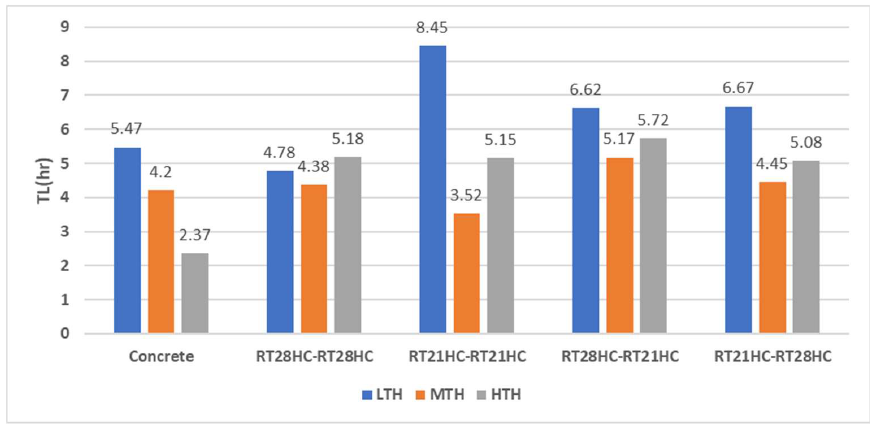
Figure 16. TL values for concrete-only samples and samples with integrated PCMs.